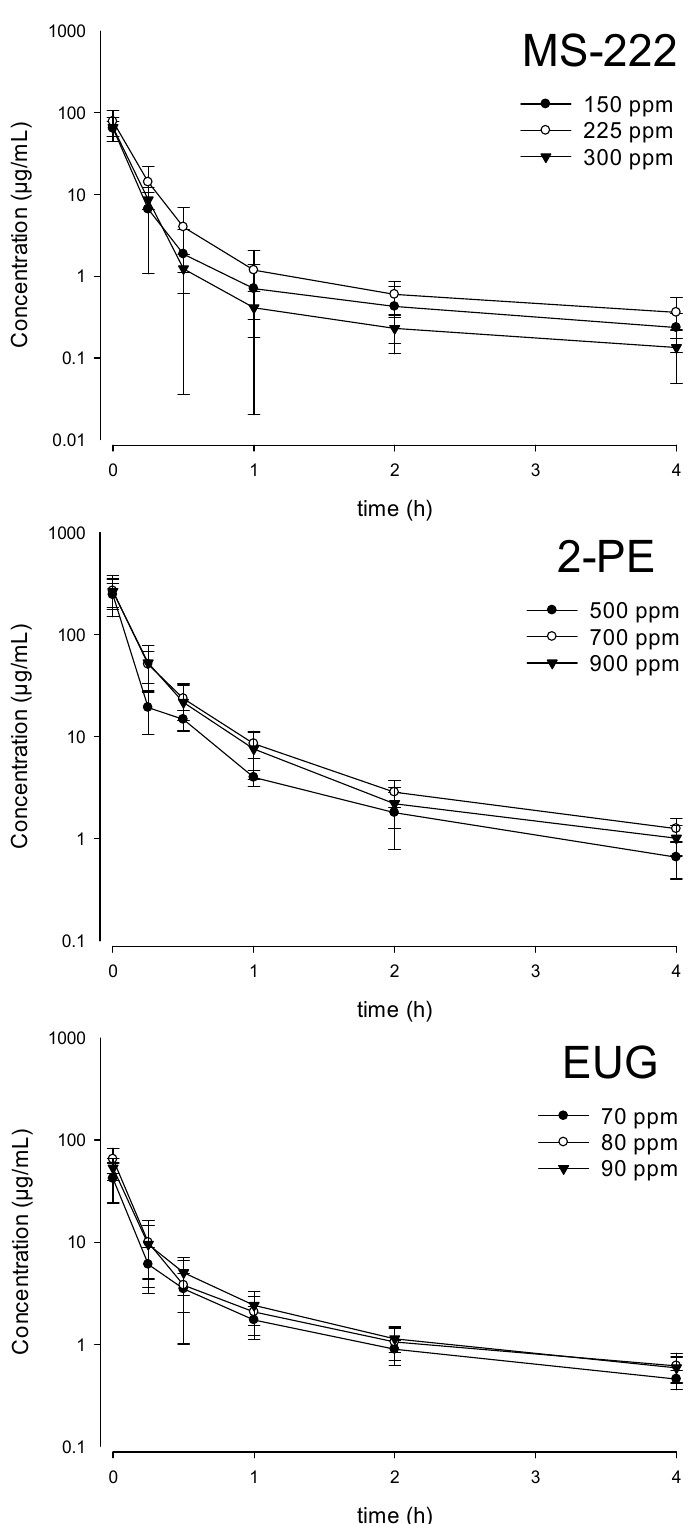
Figure 2. Serum concentration time profile (mean ± SD) of tricaine methanesulfonate (MS-222), 2-phenoxyethanol (2-PE), and eugenol (EUG) in Nile tilapia during the recovery phase following immersion at 3 different doses at 28 °C ( n = 7).